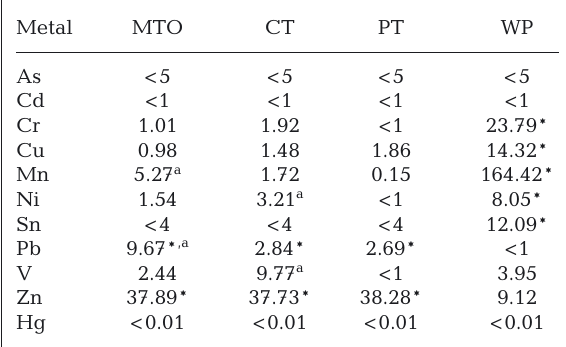
Table 4. Trace metal content of different compounds com- monly used to clean and maintain mussel rafts (mg kg −1 ). MTO: mixture of petroleum tars and diesel combusted oil; C: coal tar; PT: tar of pine wood; WP: waterproof paint. *Signif- icant increase of metal concentration in the WP relative to the tars analysed and in the tars relative to the WP; a signi - ficant increase of metal concentration in each tar analysed regarding the other tars (p < 0.01) (Tukey’s test)